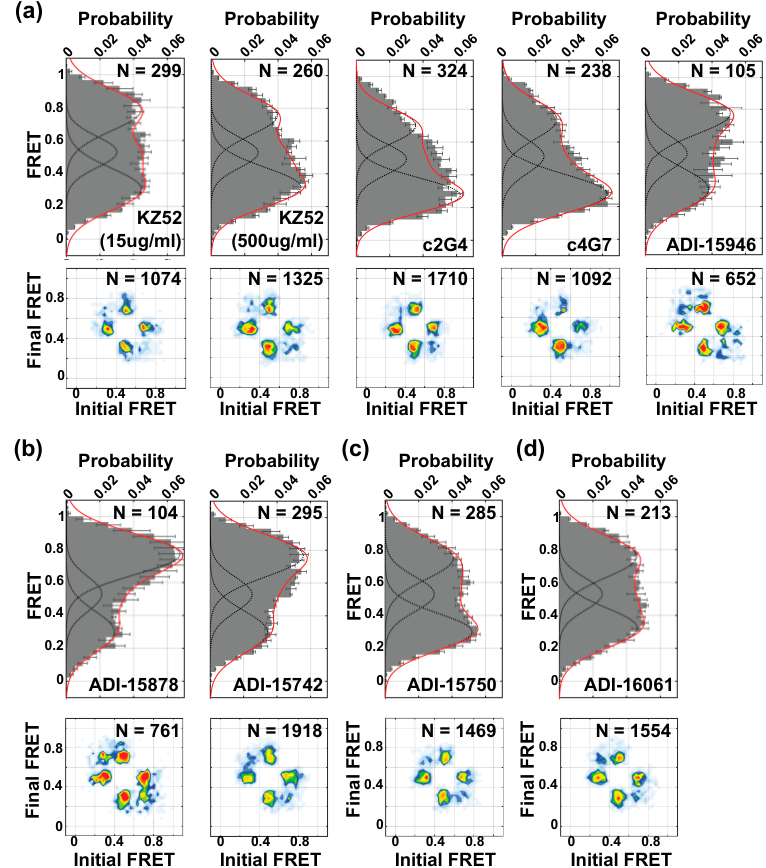
Figure 5. Neutralizing antibodies stabilize distinct EBOV GP Δ muc conformations. Population FRET histograms and corresponding TDPs, displayed as in Figures 3 and 4, for EBOV GP Δ muc in the presence of 15 µg/mL (unless otherwise noted) of the following: ( a ) Base-binding antibodies KZ52, c2G4, c4G7, and ADI-15946; ( b ) base-binding antibodies that contact the GP2 fusion loop and adjacent GP1 protomer ADI-15878 and ADI-15742; ( c ) Glycan-cap-binding antibody ADI-15750; and ( d ) GP2 stalk-binding antibody ADI-16061.